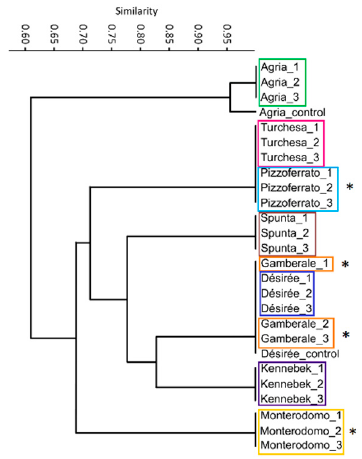
Figure 4. Dendrogram of the eight potato genotypes created using unweighted pair group method with arithmetic mean (UPGMA) cluster analysis of microsatellite (SSR) marker data; the Dice coefficient was used to estimate the degree of similarity among genotypes . Asterisks identify the accessions from Majella National Park.